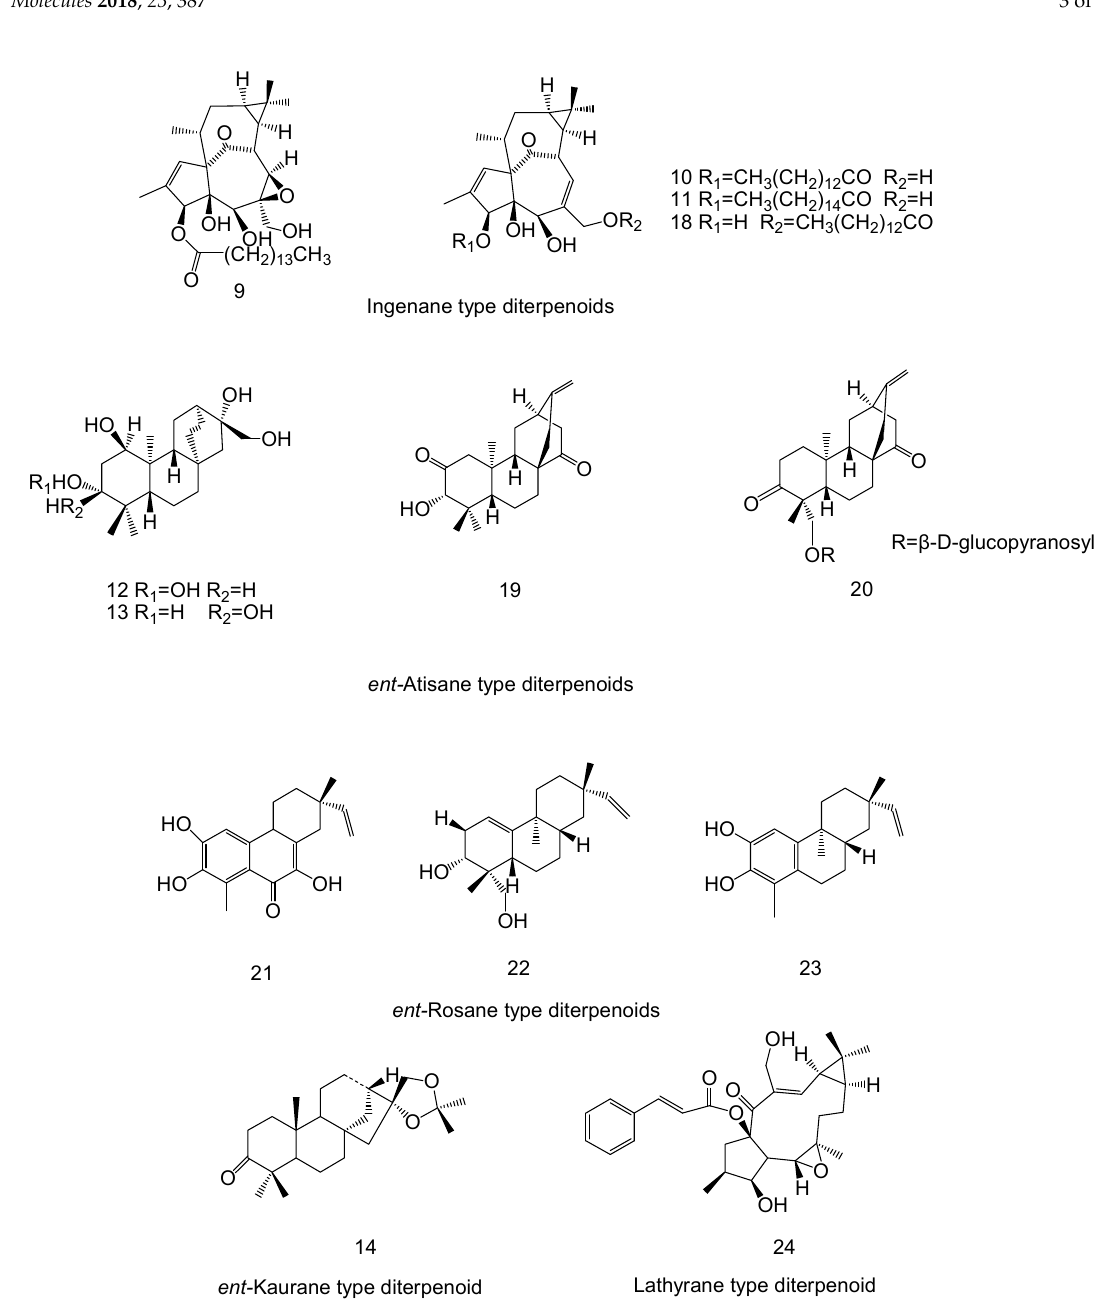
Figure 2. The chemical structures of ingenane-, ent -atisane-, ent -rosane-, ent -kaurane- and lathyrane-type diterpenoids derived from E. fischeriana